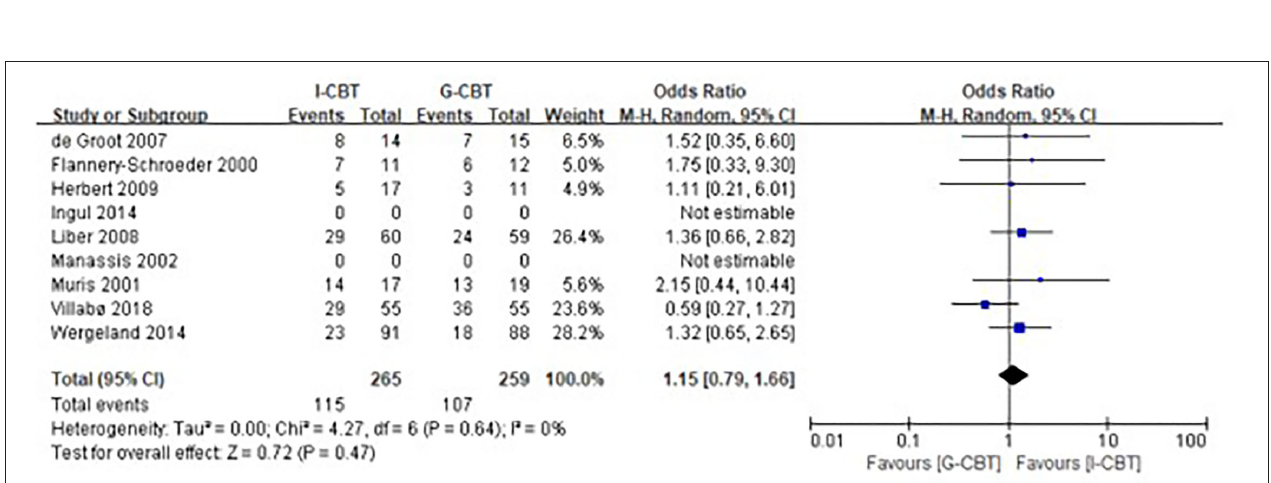
Frontiers in Psychiatry | www.frontiersin.org